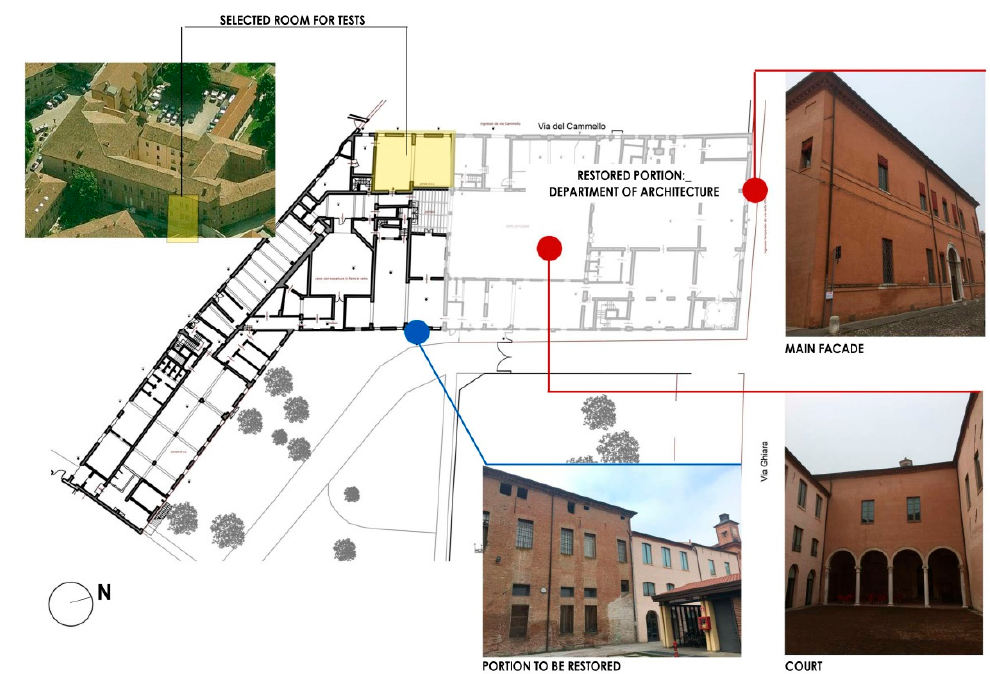
Figure 1. Ground floor plan of Palazzo Tassoni and location of the room where the experiment is carried out. External views of the surrounding buildings.